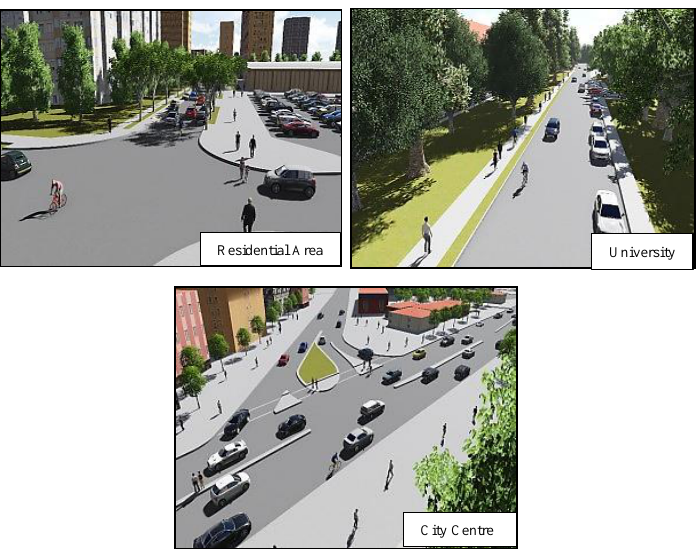
Figure 2. The current Turkish urban locations in 2015.